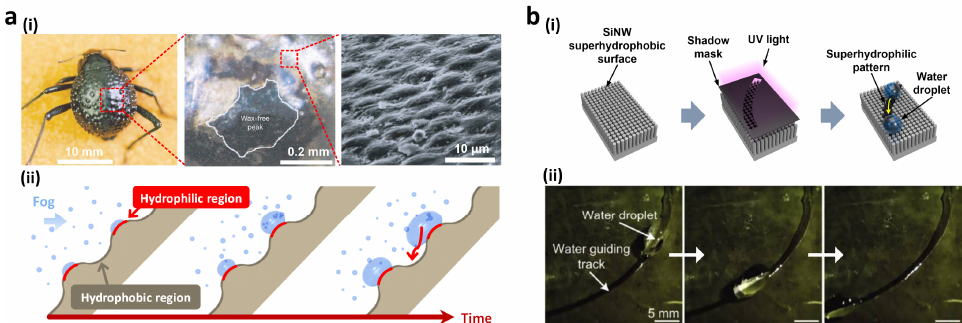
Figure 5. ( a ) Water ‐ capturing surfaces of fused Stenocara beetle overwings: ( i ) Photograph and SEM ( a ) Water-capturing surfaces of fused Stenocara beetle overwings: ( i ) images of wax ‐ stained (colored) and unstained beetle wing regions (wax ‐ free; black); ( ii ) Time ‐ dependent growth of water droplets in a fog ‐ laden wind; ( b ) Hydrophilic ‐ patterned